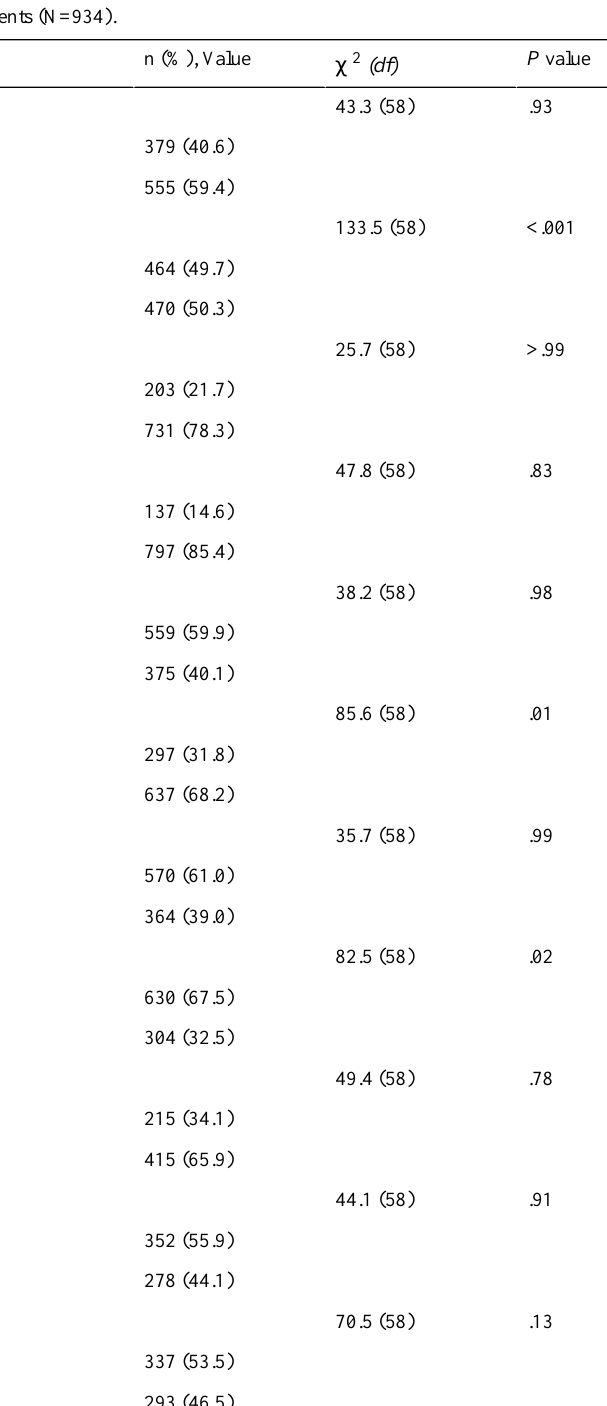
Table 6. Dichotomous geographical characteristics of the respondents (N=934).